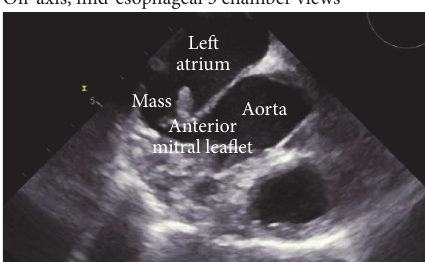
Figure 2: Transesophageal echocardiogram (TEE) image showing a pedunculated mass on the atrial aspect of the posterior leaflet of the mitral valve before surgical resection of the CPFE.